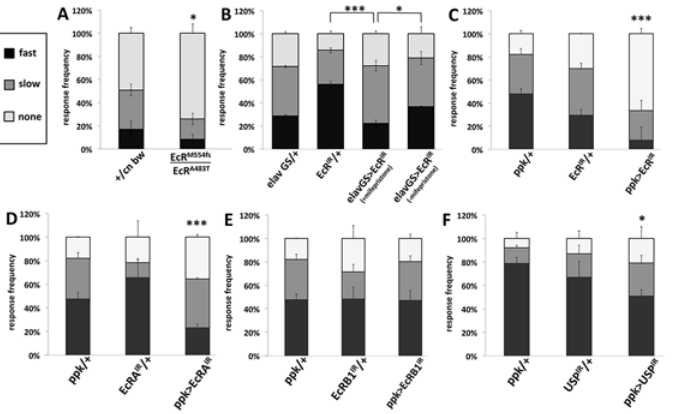
Fig 2. Ecdysone receptor mutants are less sensitive to noxious thermal stimulation. Foraging third instar larvae were gently touched on their dorsal surface with a probe at 45°C. Larvae responding with a nocifensive roll were classified as fast ( < 6 seconds) or slow (between 6 and 20 seconds), or nonresponders if they did not respond within 20 seconds. Distributions were compared using Fisher ’ s exact test. Asterisks indicate statistically different results ( * is p < 0.05, *** is p < 0.001). N > 90. (A) Mutants bearing one null allele ( EcR M554fs ) and one temperature sensitive allele ( EcR A483T ) were significantly less sensitive than controls (+ = Canton-S) comprising the genetic backgrounds of each mutation. (B) EcR RNAi was driven by the mifepristone-inducible neuron-specific elav-Geneswitch . (C-F) Various EcR and a USP RNAi were driven by ppk1 . 9-Gal4 , specific to the nociceptive class IV multidendritic neurons.